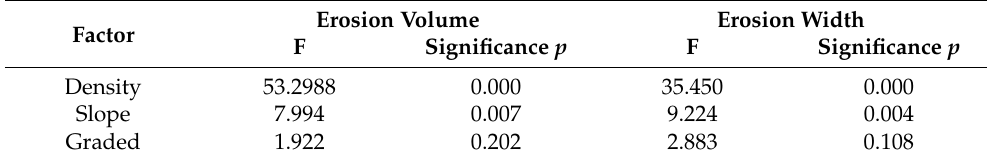
Table 4. Test for effect of each influencing